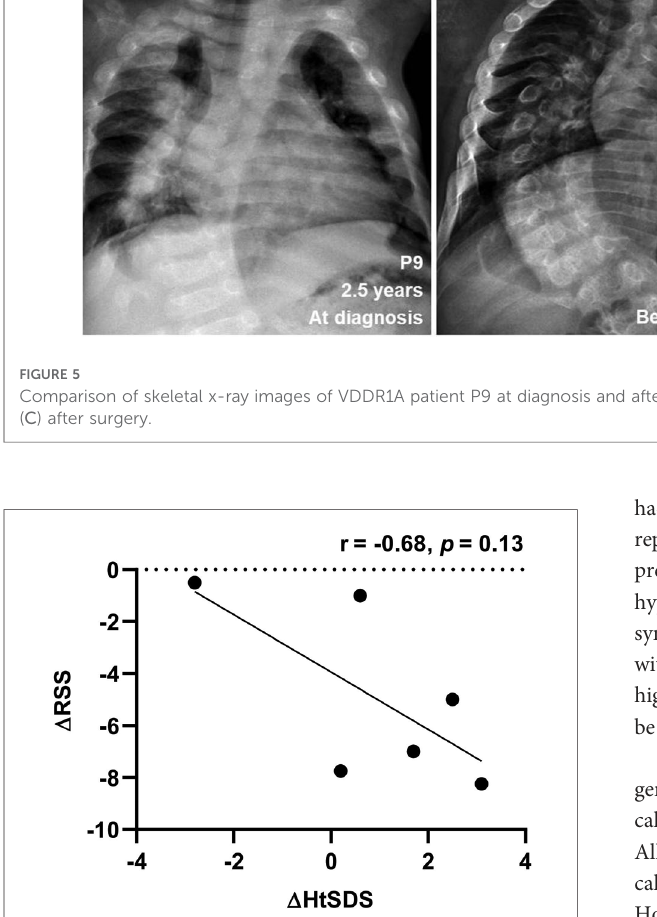
FIGURE 6 Correlation between HtSDS and RSS changes. Δ RSS was calculated by RSS at the last visit minus RSS at diagnosis. Δ HtSDS was calculated by HtSDS at the last visit minus HtSDS at diagnosis.